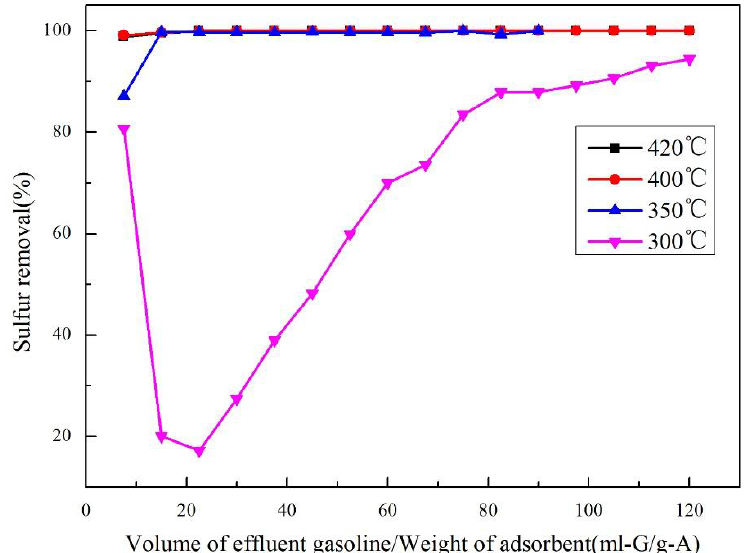
Figure 7. Desulfurization performance of unreduced adsorbents at different temperatures.